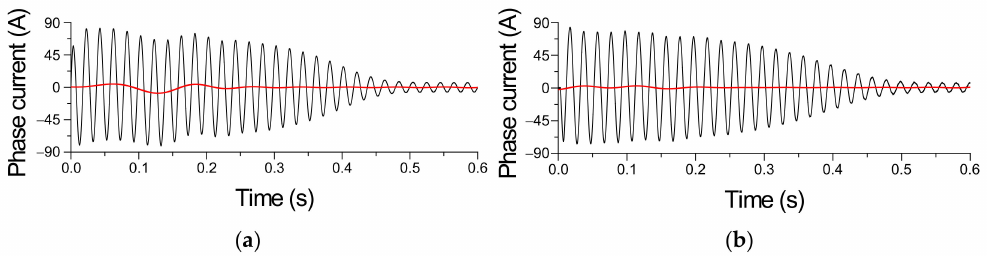
Figure 4. Motor phase current waveforms during start-up: ( a ) simulated; ( b ) measured.